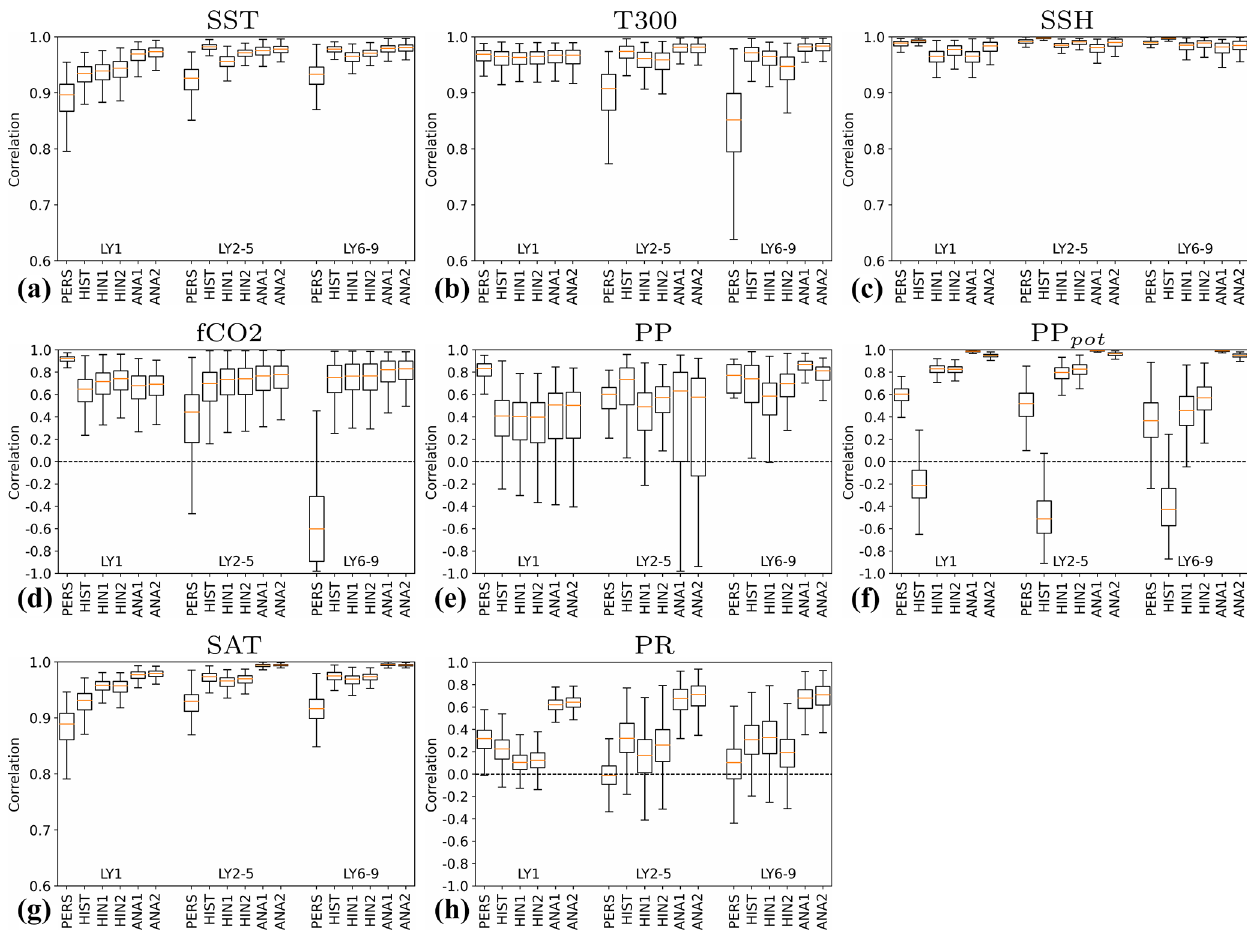
Figure 22. Correlation skill for global means of sea surface temperature (SST, a ), 0–300m temperature ( T 300, b ), sea surface height (SSH, c ), surface CO 2 flux ( f CO 2 , d ), column-integrated primary production (PP, e, f ), 2m air temperature (SAT, g ) and land precipitation (PR, h ). The box plots are constructed from 1000 bootstrap realizations of the correlations. Potential predictability ∗ of PP (f) uses assim-i1 instead of real observations. The plotted correlation range varies for different